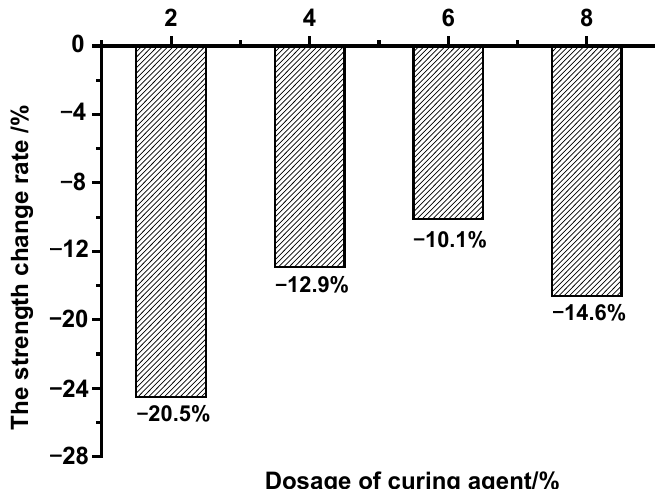
Figure 12. The strength change rate of the flexible curing agent stabilized silt.